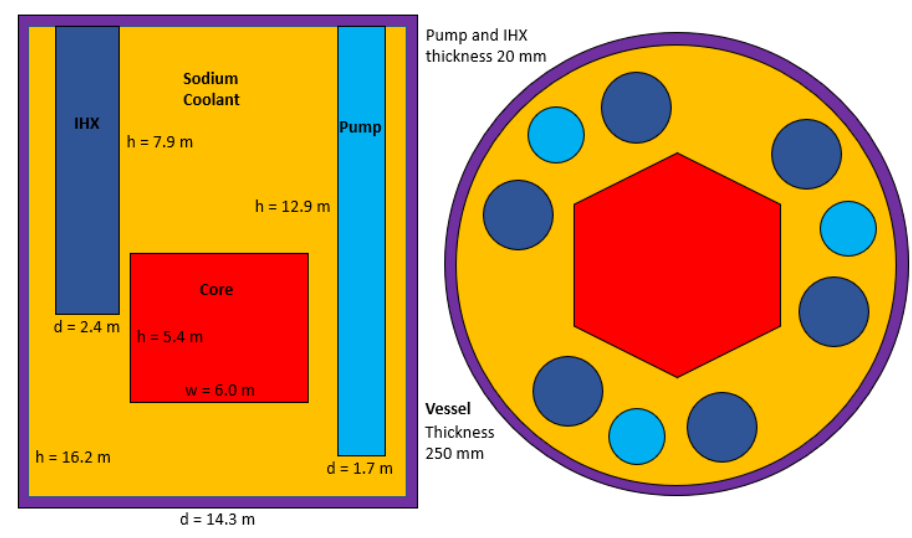
Figure 1. Horizontal and Vertical slice of MCNP Geometry for ESFR